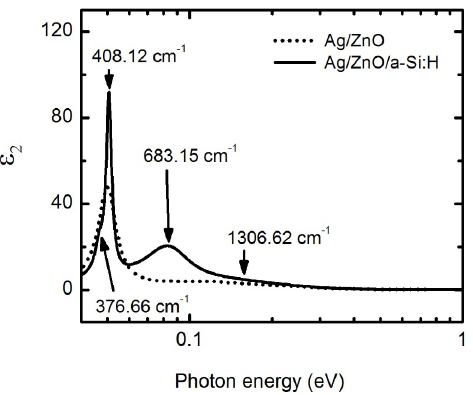
Figure 9. Comparison of lower energy features in ε 2 as a function of photon energy for ZnO with (solid line) and without (dotted line) over ‐ deposition of a ‐ Si:H. Parameters describing the sample without and with over ‐ deposition of are listed in Tables 4 and 5, respectively. line) and without (dotted line) over-deposition of a-Si:H. Parameters describing the sample without and with over-deposition of are listed in Tables 4 and 5